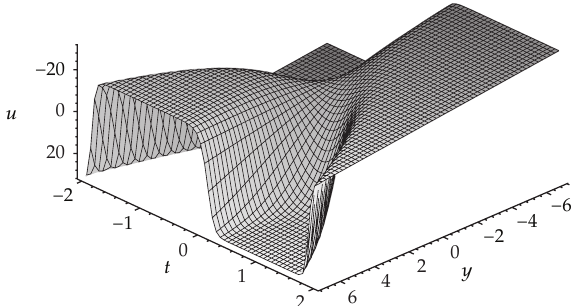
Figure 4: Local structure of 𝑢 3 (𝑥, 𝑦,𝑡) is shown as 𝑥 = 1 , 𝛼 = 1 , 𝛽 = 10 , 𝑝 = −1 , 𝑞 = 1 , 𝛾 = 6